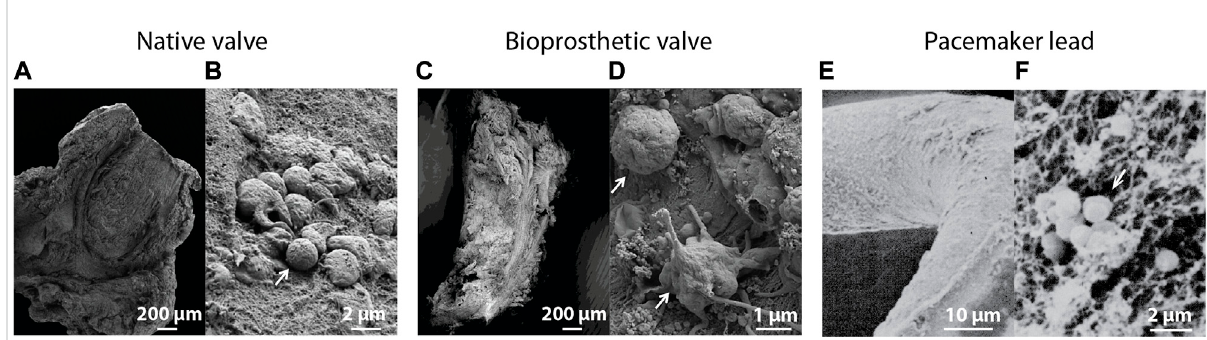
FIGURE 4 Scanning electron microscopic images of (A) an infected native heart valve with (B) a corresponding magni fi ed image showing intact bacteria on the tissue surface (Oberbach et al., 2017). (C) Overview of an infected biological prosthetic valve with (D) a corresponding magni fi ed image showing intact bacteria surrounded by a fi brous surface (Oberbachet al., 2017). (E) Visualizationof a bio fi lm on thesurface of apacemakerlead with (F) a corresponding magni fi ed image showing bacteria surrounded by a fi brillar substrate (Marrie and Costerton, 1984). White arrows indicate the presence of bacteria. Images were adapted with permission from the original publishers and used as